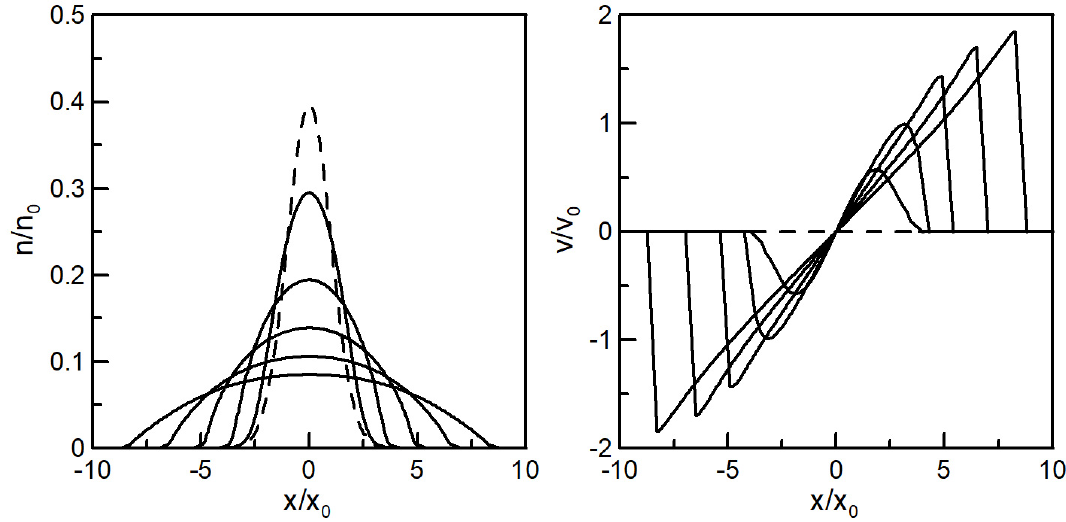
Figure 4. The time evolutions of the mass distribution and the velocity field are shown on the left and right panels, respectively. The Reynolds number R e = 10 is set. The initial values are shown by dashed lines. Five solid lines represent the results for τ = 1,2,3,4 and 5,